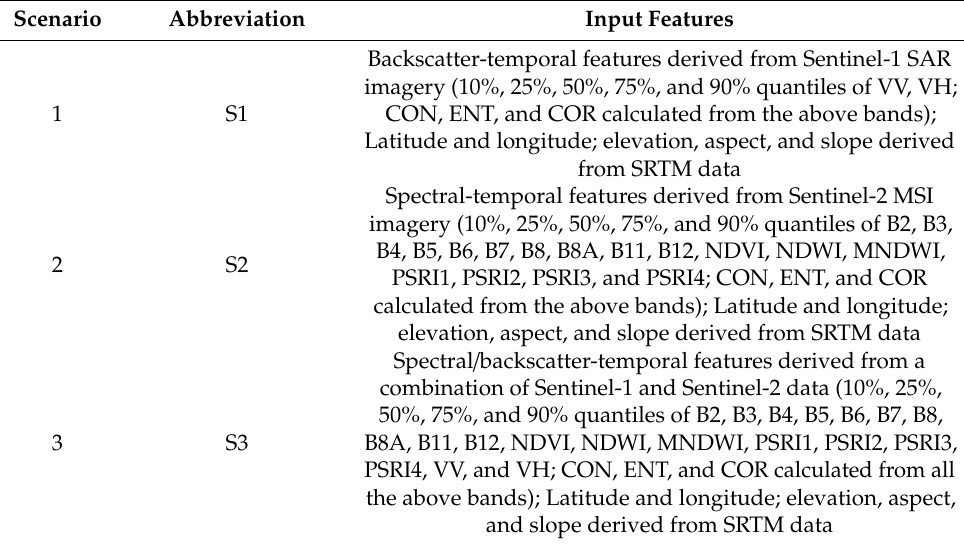
Table 4. Experiment designed in our